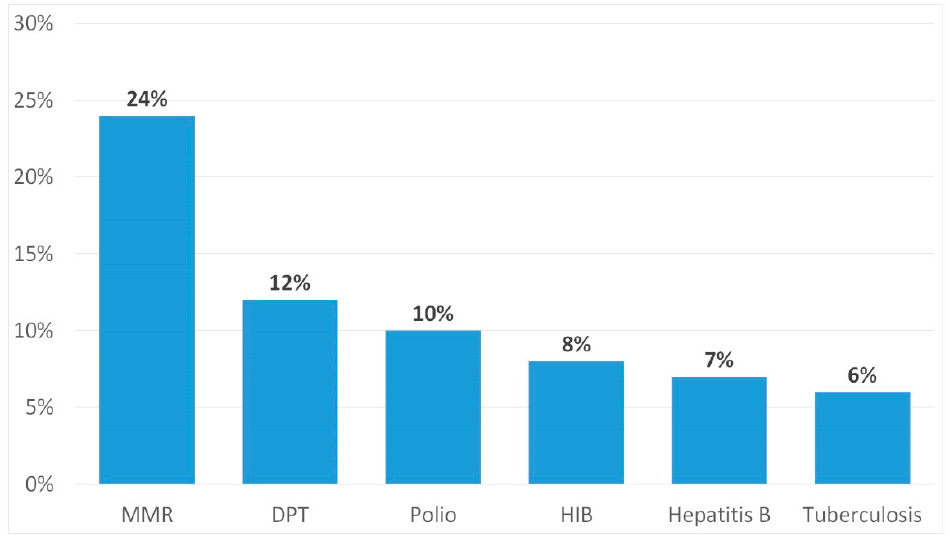
Figure 1. Refusal to vaccinate children.